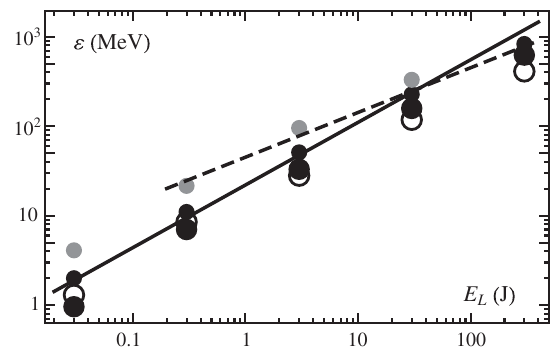
FIG. 3. Maximum proton energy for optimum target thickness vs laser energy for τ ¼ 30 fs and d ¼ 4 μ m (large black dots), d ¼ 6 μ m (small black dots), d ¼ 2 μ m (gray dots) and τ ¼ 150 fs and d ¼ 4 μ m (open circles). The black and dashed lines ½ J (cid:2)Þ 0 . 7 and ε ½ MeV (cid:2) ¼ correspond to the fits ε ½ MeV (cid:2) ¼ 22 ð E L 45 ð E ½ J (cid:2)Þ 0 . 5 [19], correspondingly. L